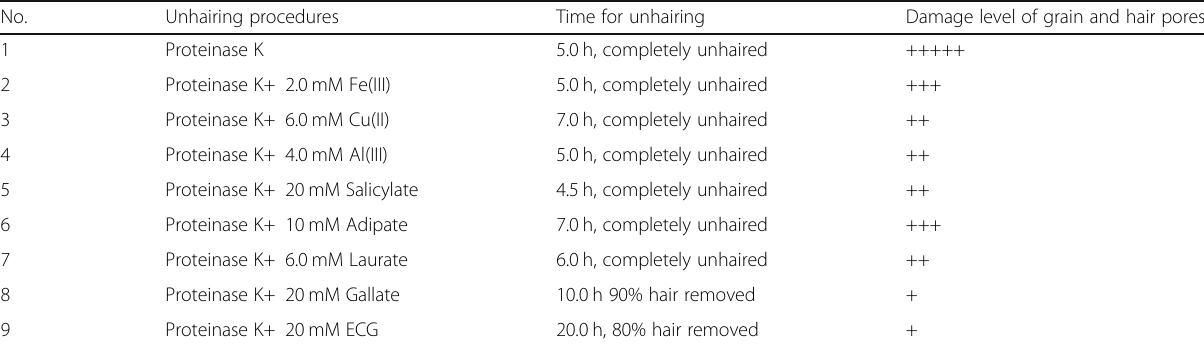
Table 2 The results of enzymatic unhairing by proteinase K (150 U/g hide) with additives at 35 °C, pH 8.0 No. Time for